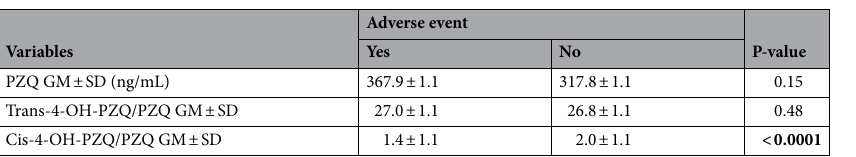
Figure 1. Type and cumulative incidence of MDA associated adverse events (AEs) during the 7-day follow-up.